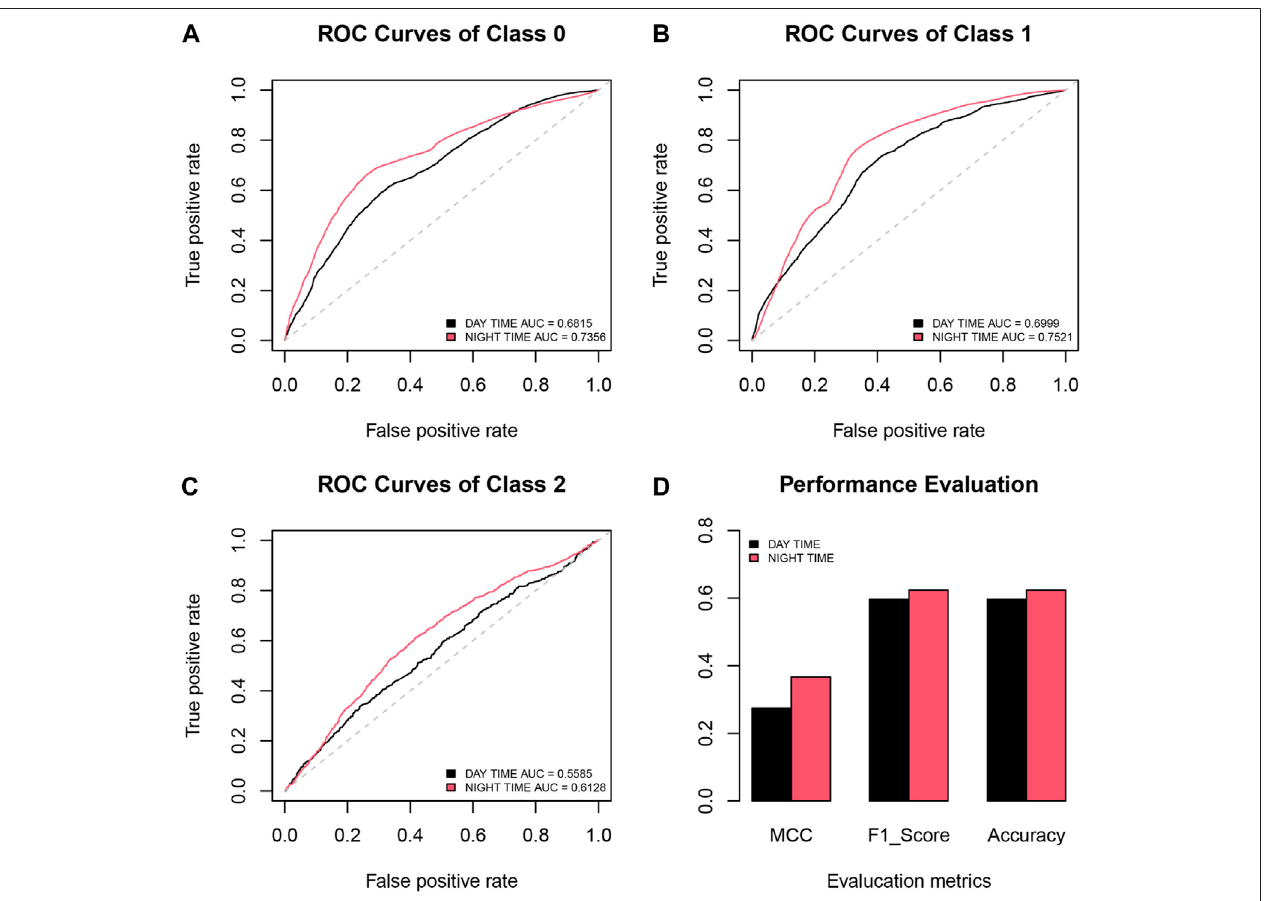
FIGURE 3 | Receiver operating characteristic (ROC) curves displaying the performance comparison between model use in the nighttime and daytime data for (A) class 0, (B) class 1 and (C) class 2. (D) Bar plot curves of Matthews correlation coef fi cient (MCC), F1 score, and accuracy comparing model performance for nighttime and daytime data